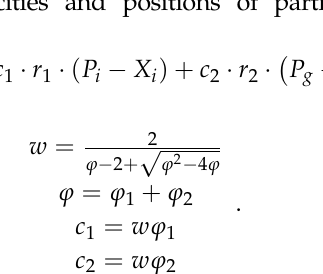
Figure 4. Flowchart of particle swarm optimization/genetic algorithm (PSO/GA) parallel algorithm. Step 4: PSO stage: The velocities and positions of particles are updated according to Equations